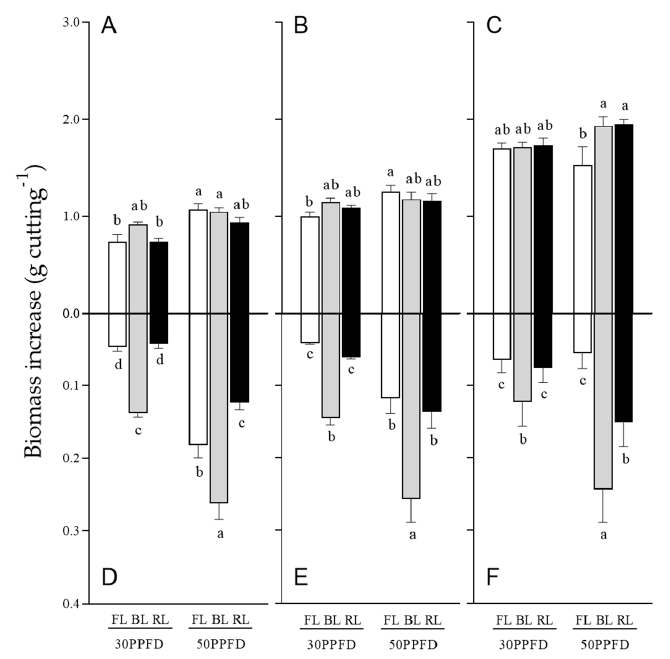
Figure 5. ( A – C ) Shoot and ( D – F ) root growth of ( A , D ) apical-, ( B , E ) middle-, and ( C , F ) basal- position rosemary cuttings irradiated with different photosynthetic photon flux densities (PPFDs) of fluorescent lamp light (FL), blue light (BL), and red light (RL) for 4 weeks. Error bars indicate the mean ± SE from three replicates (n = 8). Different letters indicate statistical differences determined by Tukey’s HSD test at p < 0.05.